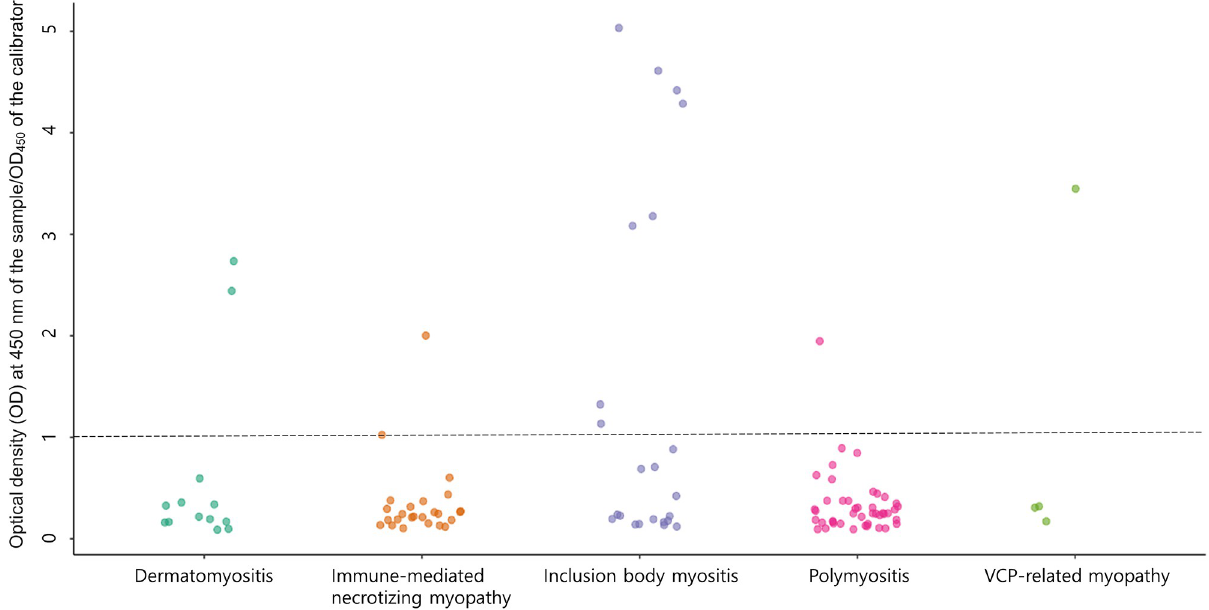
Fig 1. Anti-cytosolic 5’-nucleotidase 1A (NT5c1A) antibody ELISA. Antibodies reactive with recombinant NT5c1A protein by ELISA in sera from patients with inflammatory myopathy and valosin-containing protein (VCP)-related patients with myopathy. The cut-off level for positivity is indicated by the broken line.